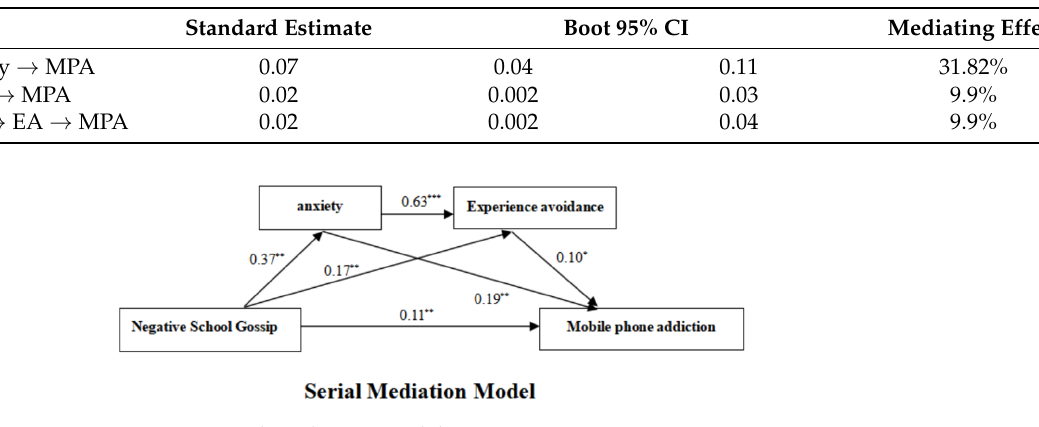
Figure 1. Serial Mediation Model. Note. * p < 0.05, ** p < 0.01, *** p < 0.001.